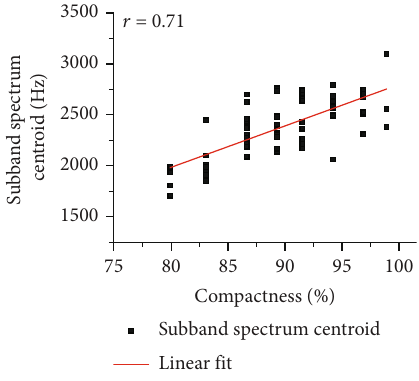
Figure 12: Correlation graphs of soil samples with di ff erent compaction degrees under the action of 65(L) N hammering force and the centroid of sound subband spectrum.